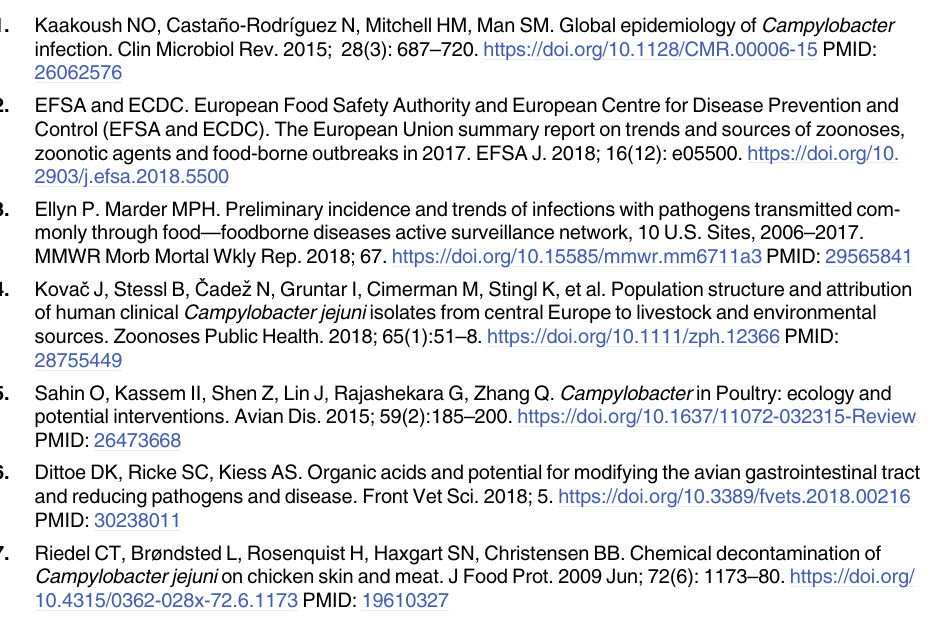
S1 Table. Campylobacter jejuni strains used in this study. S2 Table. Susceptibility of Campylobacter jejuni broiler and turkey strains to the range of tested antibiotics, as MICs and corresponding sensitivity (S) or resistance